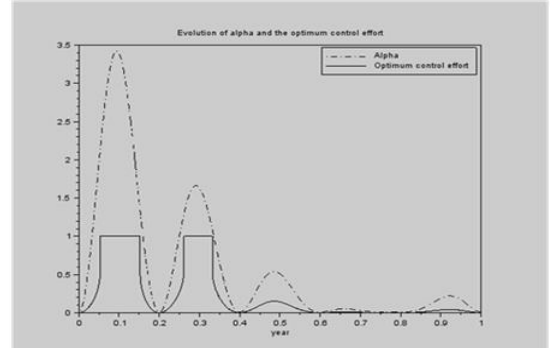
Fig3 : Optimum control effort over a one-year period θ 0 = 0 . 5 , θ 1 = 1 − 0 . 4 .